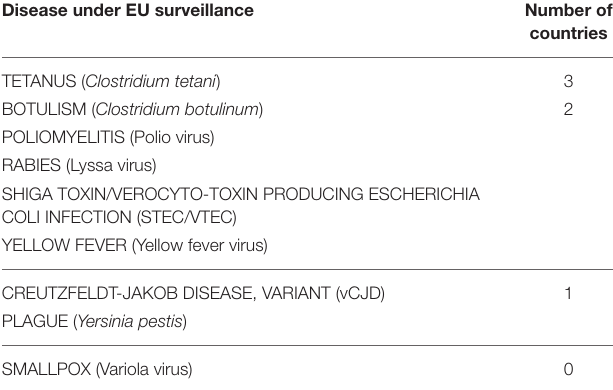
TABLE 2 | Western Balkan countries’ capacities to confirm cases by primary and/or reference laboratory for the following notifiable 53 communicable diseases as per EU acquis